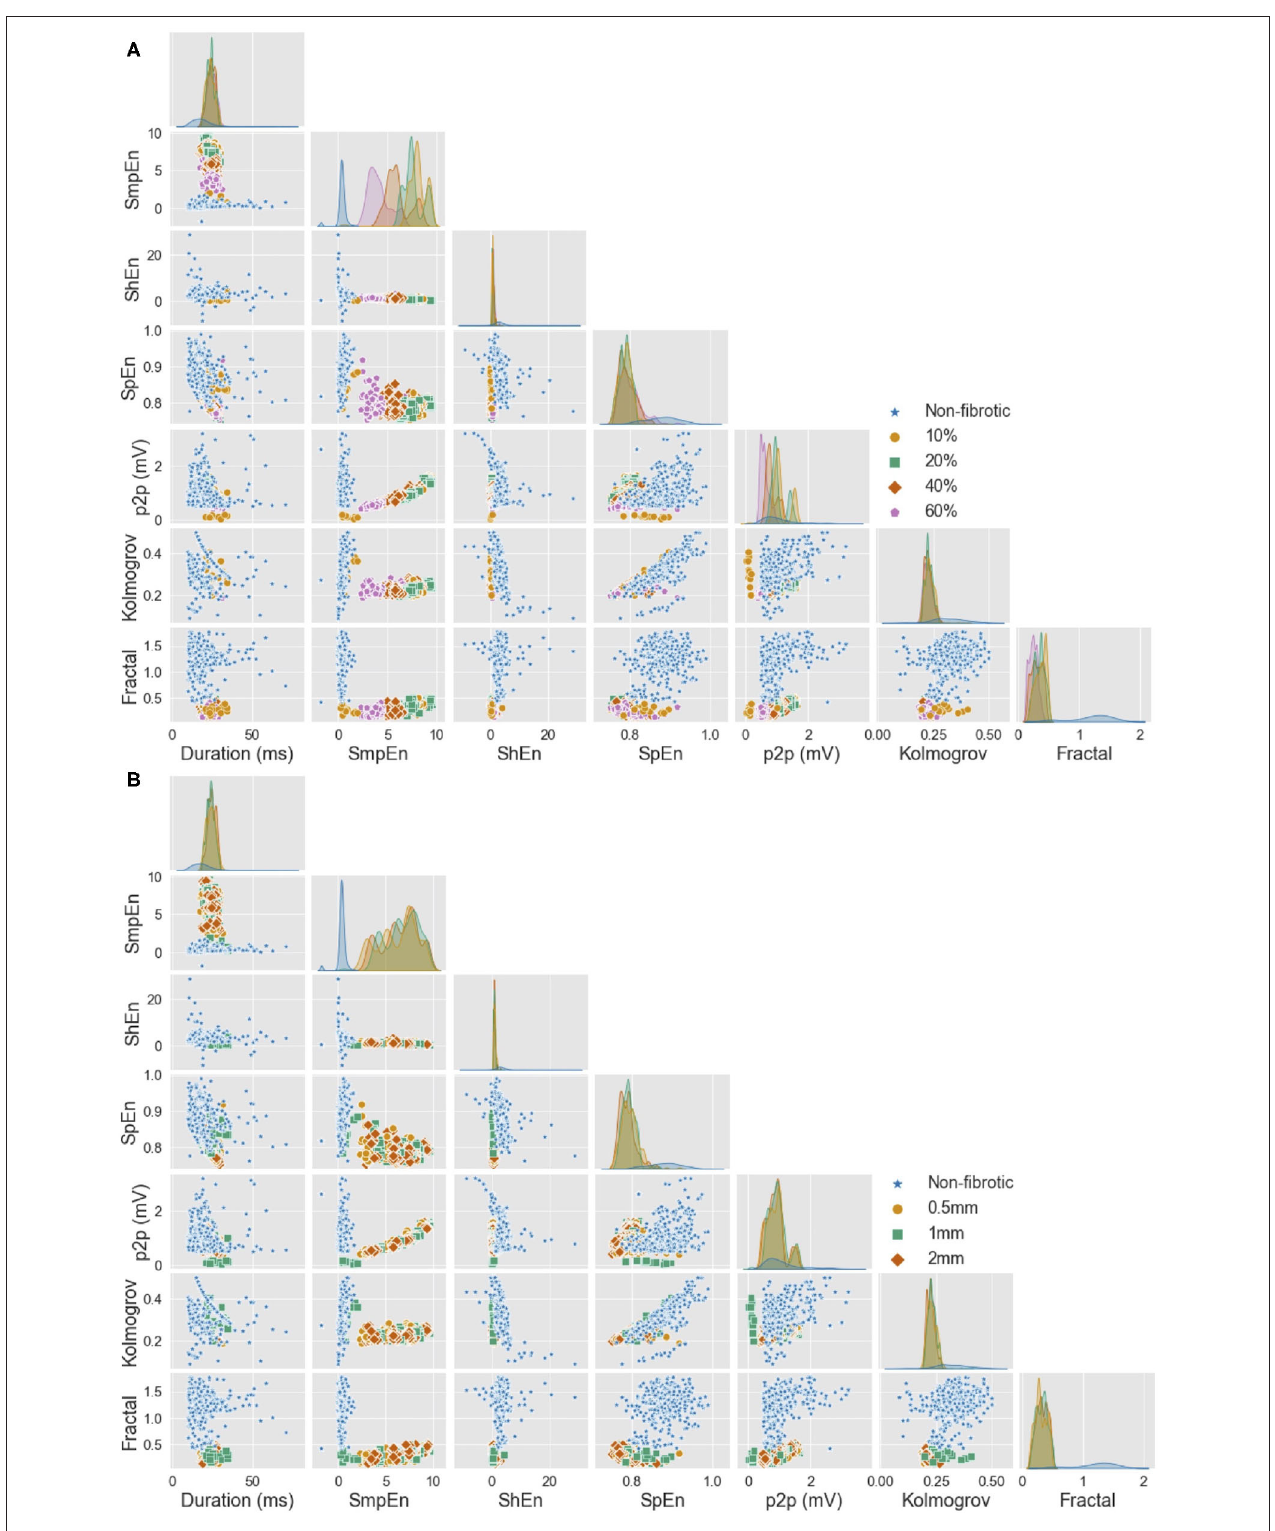
FIGURE 5 | Feature distribution for all in vivo and in silico electrograms (including noise). Single feature distribution can be observed in the diagonal and the combination of two features is reflected in the scatter plots. (A) Features split by different densities of fibrosis. (B) Features split by different degrees of transmurality. Duration, duration of the active segment (ms); SmpEn, sample entropy; ShEn, shannon entropy; SpEn, spectral entropy; p2p, peak-to-peak amplitude (mV); Kolmogorov, Kolmogorov complexity; Fractal, fractal dimension. Reused from Sánchez et al. (2021).